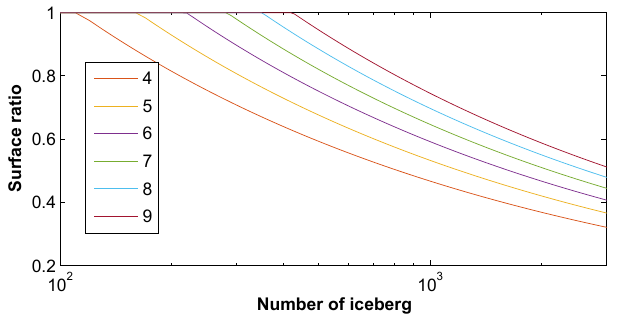
Figure A2. Proportion of the total surface represented by icebergs with areas between 0.1 and 4 to 9km 2 as a function of the total number of